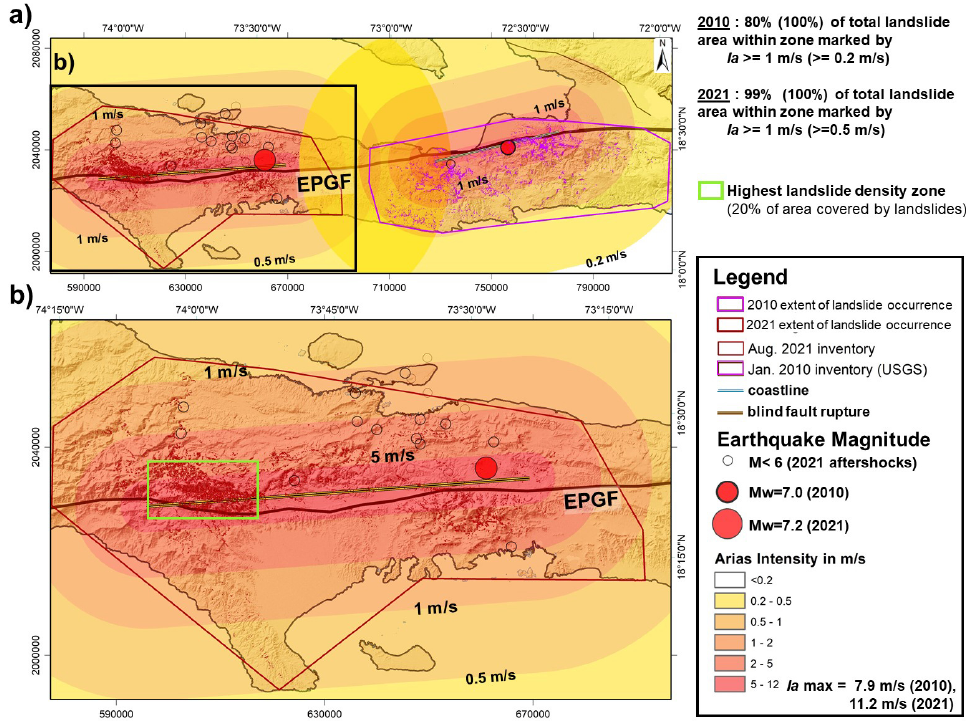
Figure 8. (a) Arias intensity (Ia) attenuation maps computed (by using Eq. 7b, by Keefer and Wilson, 1989) for the 2010 and 2021 main shocks in Haiti; see also indication of the percent of total surface area of landslides observed for different Ia thresholds. (b) Focus on the respective map computed for the 2021